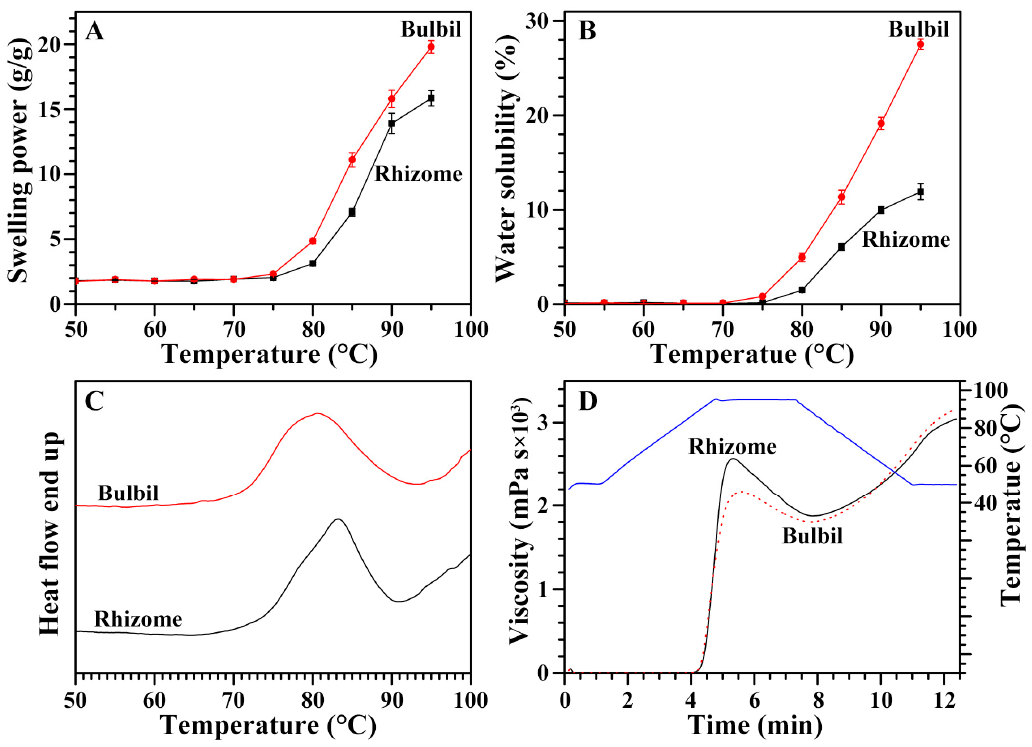
Figure 3. Swelling power ( A ); water solubility ( B ); DSC thermogram ( C ); and RVA profile ( D ) of starches from the rhizome and the bulbil of Chinese yam.